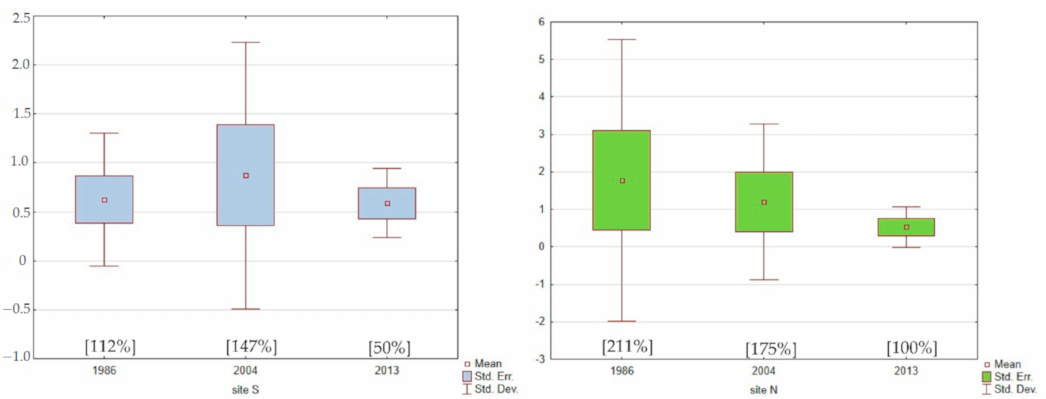
Figure 3. Temporal variability (mean values, standard error, standard deviation) of rotifer biomass [mg L − 1 ] at the sites in Lake Kortowskie; all differences were insignificant ( p > 0.05). S–the site in the southern basin of the lake, where the pipeline is located; N–the site in the northern basin of the lake; [variability indices in